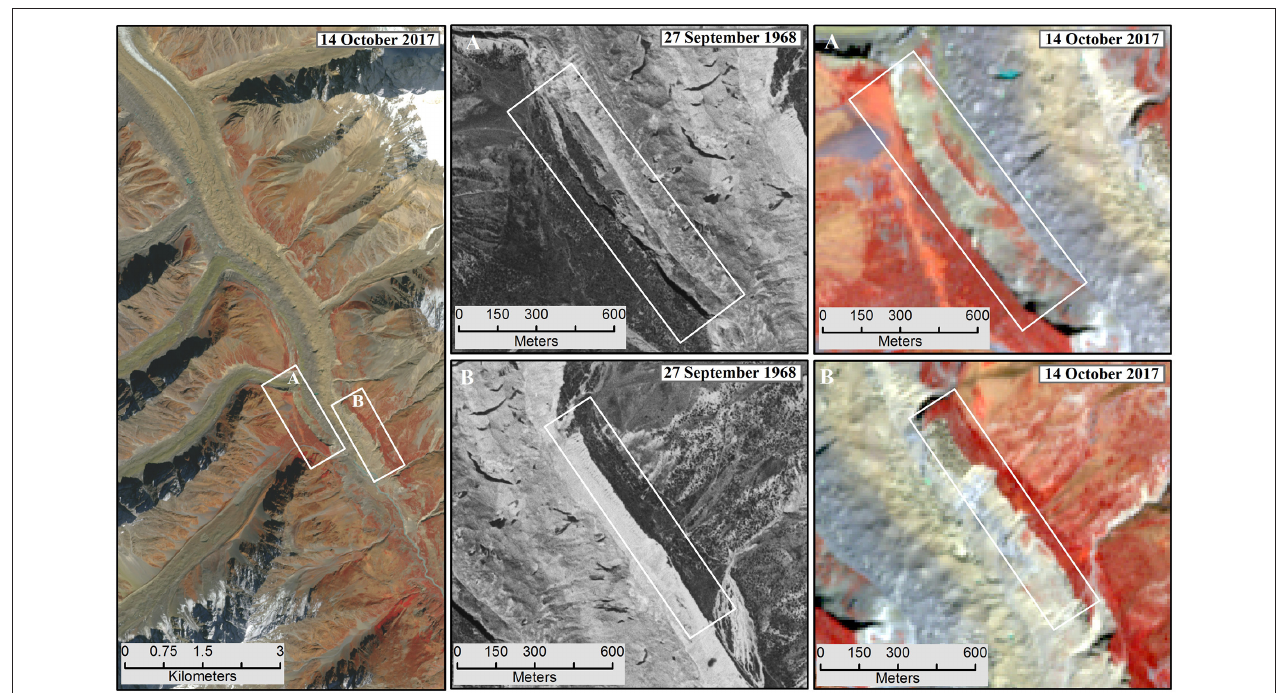
FIGURE 4 | Morphological changes of recently exposed moraine ridges on either sides of the valley glacier. White boxes show locations of deformed moraine ridges. (A,B) Show the zoomed sections of deformations in the right and left lateral moraine ridges between 1968 (Corona image) and 2017 (Sentinel 2 image), respectively.